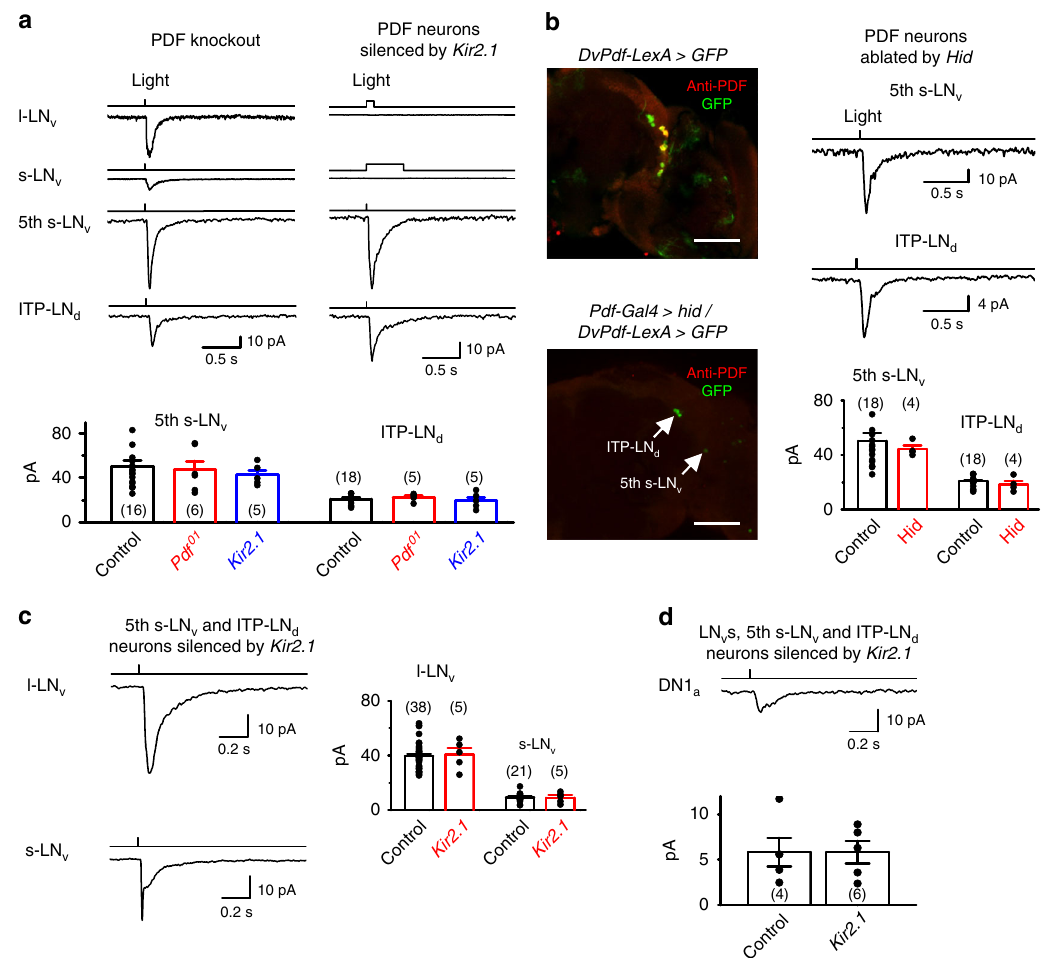
Fig. 3 Central pacemaker neurons receive visual signals in a parallel manner. a PDF is not required for light responses of pacemaker neurons. Top, responses of pacemaker neurons in Pdf 01 fl ies (left) and in fl ies with the PDF-expressing LNvs silenced by Kir2.1 (right). Under cell-attached recordings, the s-LNvs and l-LNvs show neither spontaneous nor light-induced action-potential fi ring (right, top two traces). Light-induced inward currents of fi fth s-LNv and ITP-LNd cells (right, bottom two traces, voltage clamp recordings). Light stimulation: 470 nm. Bottom, collective data of the fi fth s-LNv and ITP-LNd responses in fl ies as indicated. The responses are not signi fi cantly different among the fi fth s-LNvs or ITP-LNds under different conditions. b PDF- expressing LNvs are not required for light responses of evening pacemaker neurons. Left, overlay of PDF immunostaining and GFP fl uorescence in control fl ies (top) and in fl ies with PDF-expressing LNv ablated (bottom). Scale bar, 50 μ m. Right, light responses of the fi fth s-LNv and ITP-LNd cells (top) in fl ies with PDF-expressing LNvs ablated and collective data (bottom). The responses are not signi fi cantly different among the fi fth s-LNvs or ITP-LNds. c Left, light responses of l-LNvs (top) and s-LNvs (bottom) in fl ies with evening oscillators silenced by Kir2.1 . Right, collective data. The responses are not signi fi cantly different among the l-LNvs or s-LNvs. d Top, light responses of DN1a in fl ies with the PDF-expressing LNvs, fi fth s-LNv, and ITP-LNd silenced by Kir2.1 . Bottom, collective data. The responses are not signi fi cantly different between the control and Kir2.1 groups. Cell numbers are indicated in